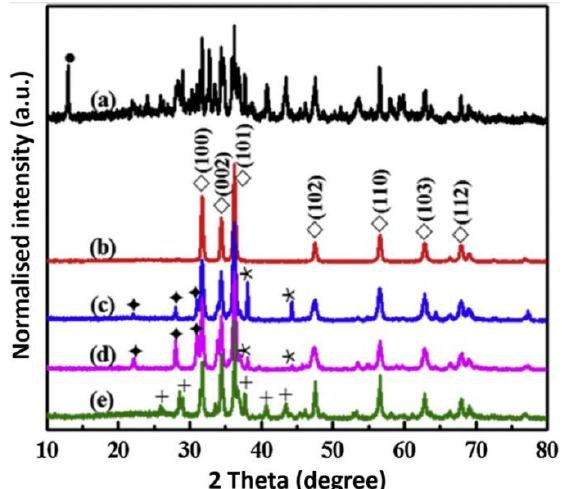
Figure 33. Normalised XRD patterns of Ag / Ag 2 SO 4 / ZnO nanostructures: ( a ) as-synthesised for molar ratio of thiourea and Ag + kept at 1:1 before calcination, ( b ) pure ZnO, ( c ) synthesised for molar ratio of thiourea and Ag + kept at 1:2, ( d ) synthesised for molar ratio of thiourea and Ag + kept at 1:1 and ( e ) catalysts after calcination synthesised for molar ratio of thiourea and Ag + kept at 2:1 ( ◊ —ZnO, ♦ —Ag 2 SO 4 , * —Ag, + —Ag 2 S, ● —Zn 5 (CO 3 ) 2 (OH) 6 ). Reprinted from [736], Copyright (2015), with permission from Elsevier [OR APPLICABLE SOCIETY COPYRIGHT OWNER]. In order to re-use permission must be obtained from the